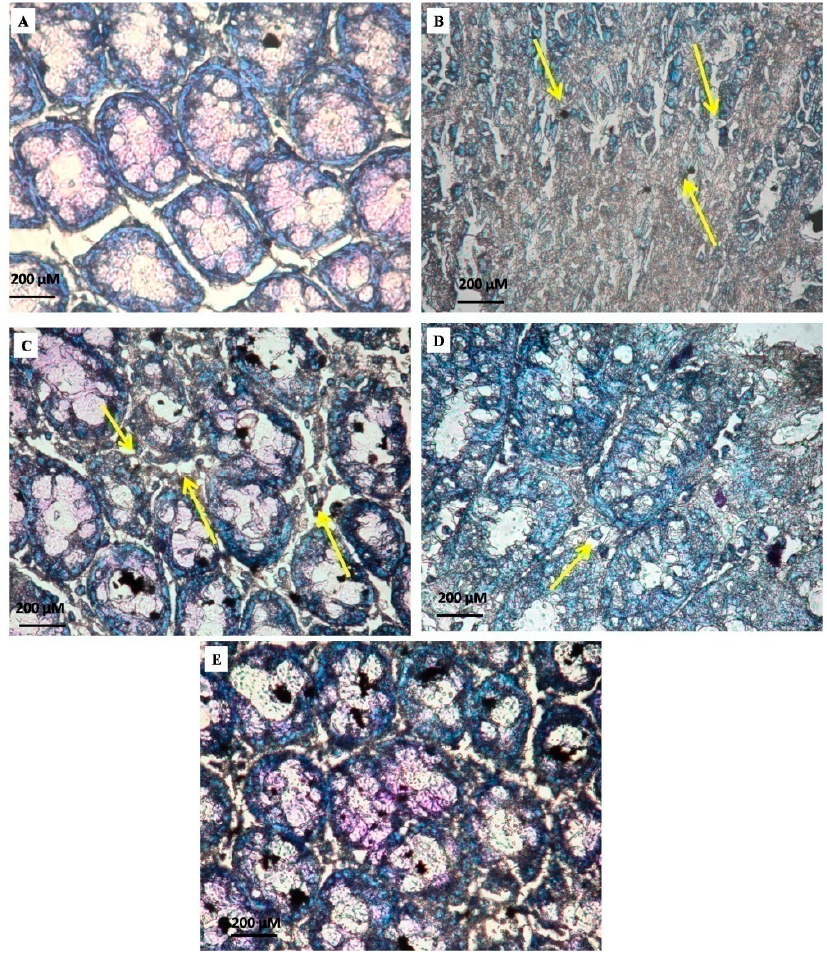
Figure 8. Photomicrographs of mast cell count. ( A ) The control group showed normal architecture lack of mast cells. ( B ) Ulcerated colonic crypts showed a considerably increased concentration of mast cells. ( C ), ( D ) showed a moderate concentration of mast cells. Additionally, 40 μ g/kg of Sal B treated Group 5 mice showed a significantly reduced concentration of mast cells ( E